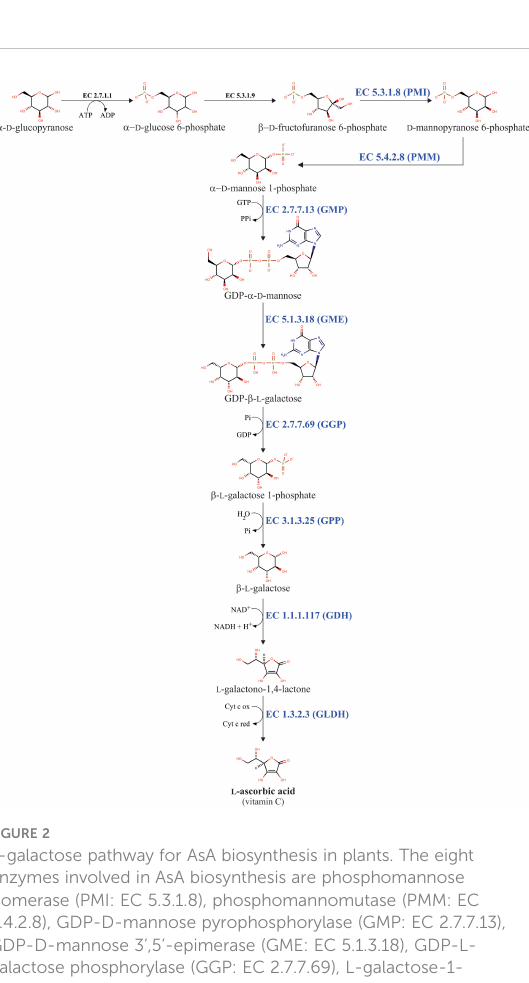
FIGURE 2 L-galactose pathway for AsA biosynthesis in plants. The eight enzymes involved in AsA biosynthesis are phosphomannose isomerase (PMI: EC 5.3.1.8), phosphomannomutase (PMM: EC 5.4.2.8), GDP-D-mannose pyrophosphorylase (GMP: EC 2.7.7.13), GDP-D-mannose 3 ’ ,5 ’ -epimerase (GME: EC 5.1.3.18), GDP-L- galactose phosphorylase (GGP: EC 2.7.7.69), L-galactose-1- phosphate phosphatase (GPP: EC 3.1.3.25), L-galactose dehydrogenase (GDH: EC 1.1.1.117), and L-galactono-1,4-lactone dehydrogenase (GLDH: EC